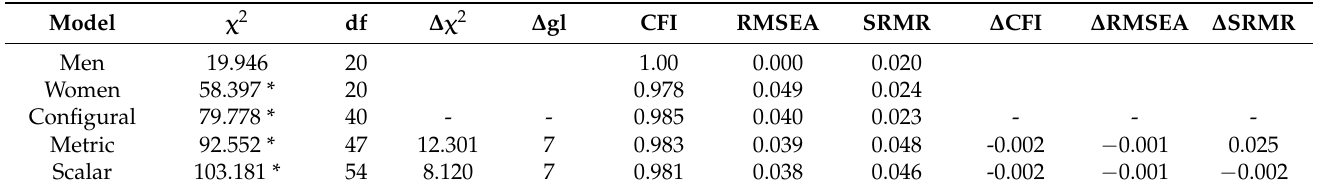
Table 5. Measurement invariance models of the Flourishing Scale by gender (reference group: